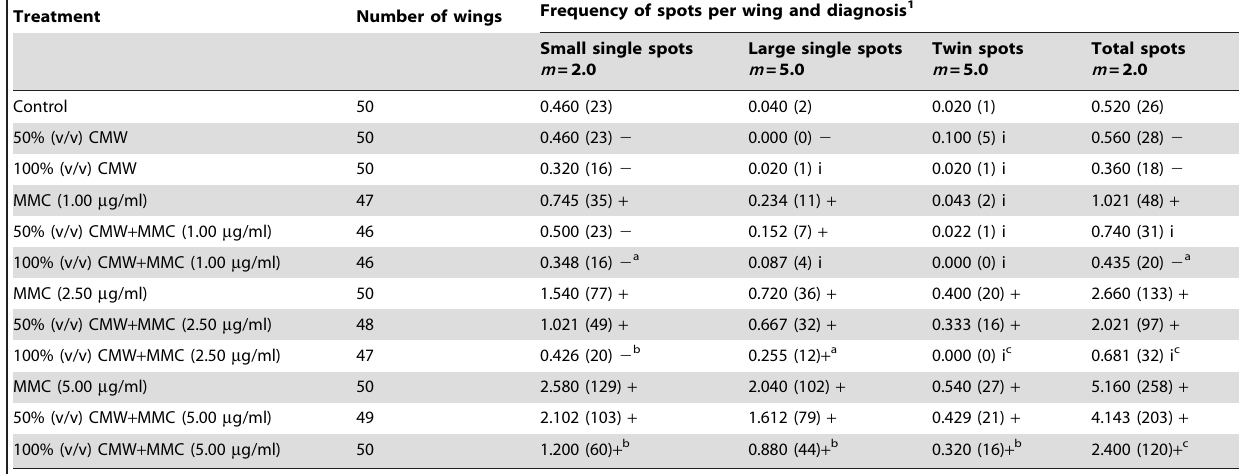
Treatment Number of